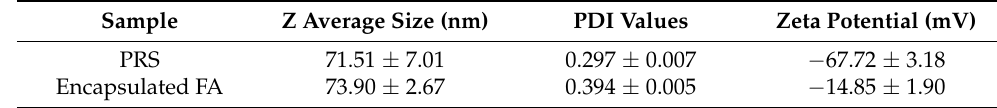
Table 3. Particle size, PDI, and zeta potential of PRS and encapsulated